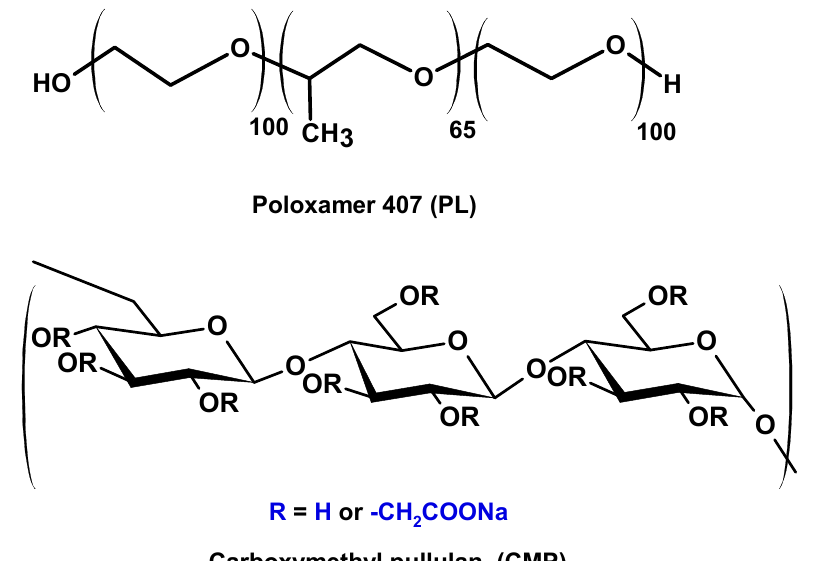
Figure 1. The chemical structure of the